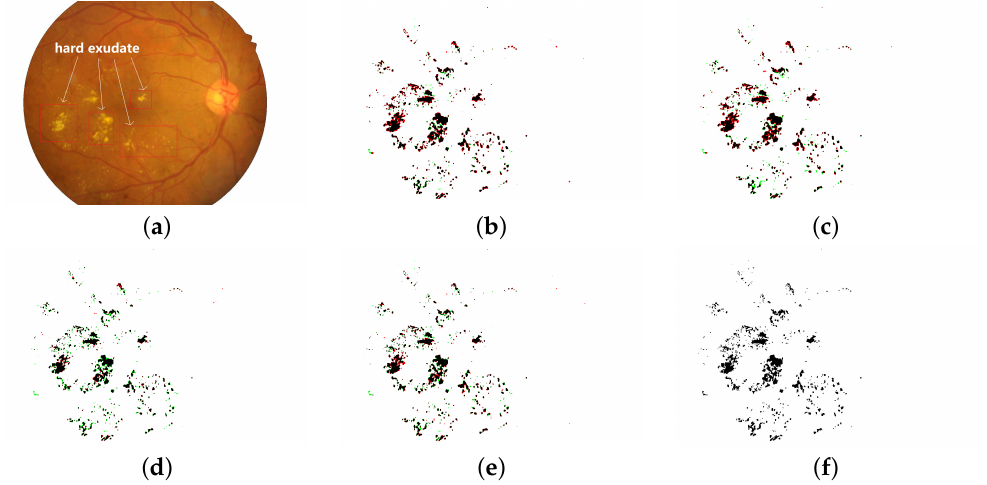
Figure 1. Hard exudate segmentation binary maps of the LightEyes and other methods on the IDRiD dataset (TPs are marked as black, FPs are marked as red, and FNs are marked as green. JI denotes Jaccard similarity index). ( a ) fundus image. ( b ) HED [7] (JI = 0.6663). ( c ) L-Seg [8] (JI = 0.6478) ( d ) LWENet [9] (JI = 0.6952). ( e ) LightEyes (JI = 0.7159). ( f ) ground